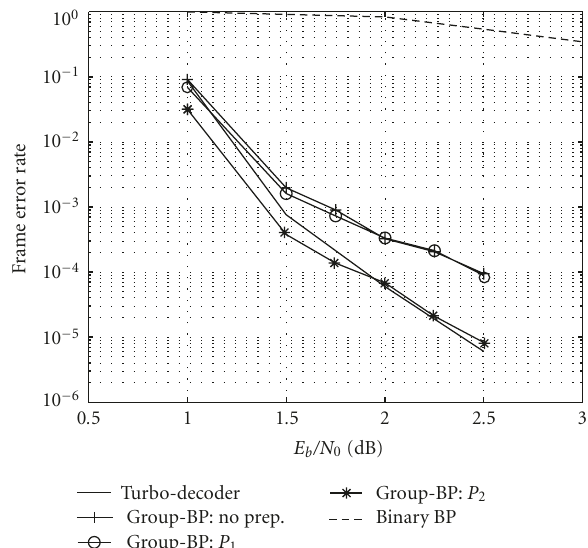
Figure 6: Performance of the group BP decoding algorithm based on di ff erent preprocessing functions for the ( R = 0 . 5, N = 3008) duobinary turbo code and comparison with the turbo decoder as used in the DVB